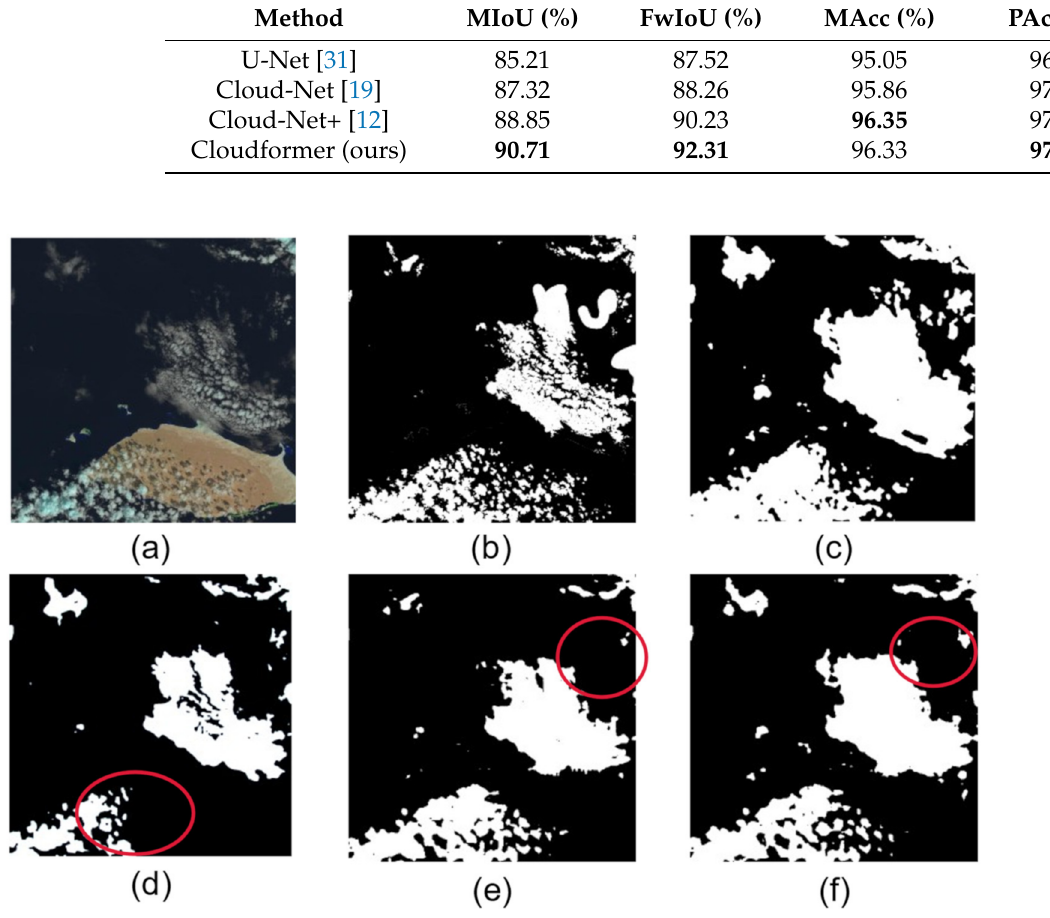
Figure 9. Comparison of different cloud detection methods on 38-Cloud dataset. ( a ) Image. ( b ) Ground truth. ( c ) Cloudformer. ( d ) Cloud-Net+. ( e ) Cloud-Net. ( f ) U-Net.